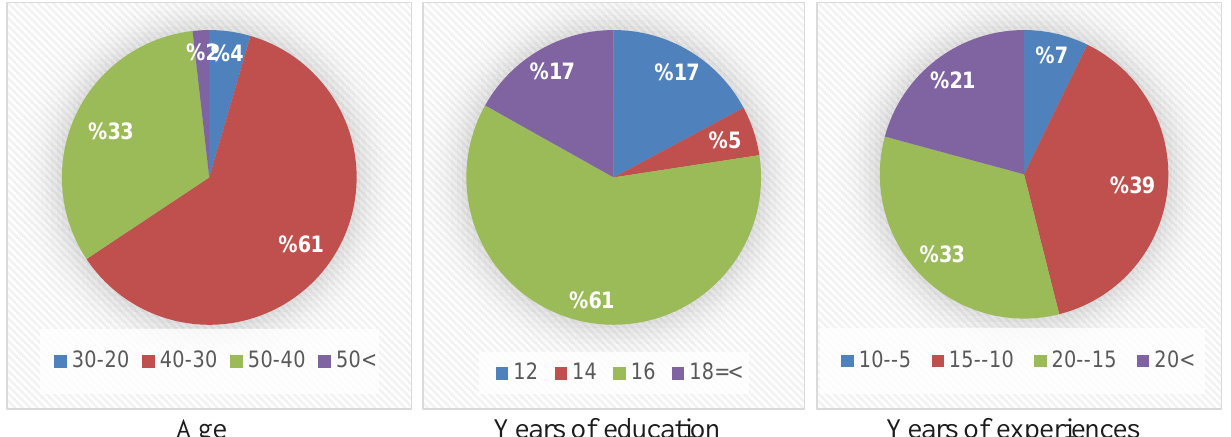
Fig. 2. Personal characteristics of the participants